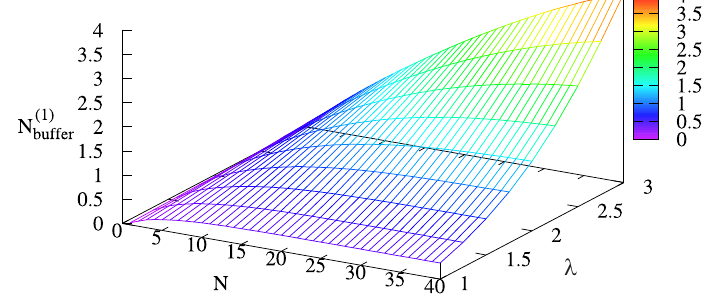
( 1 ) on N and λ . buf fer